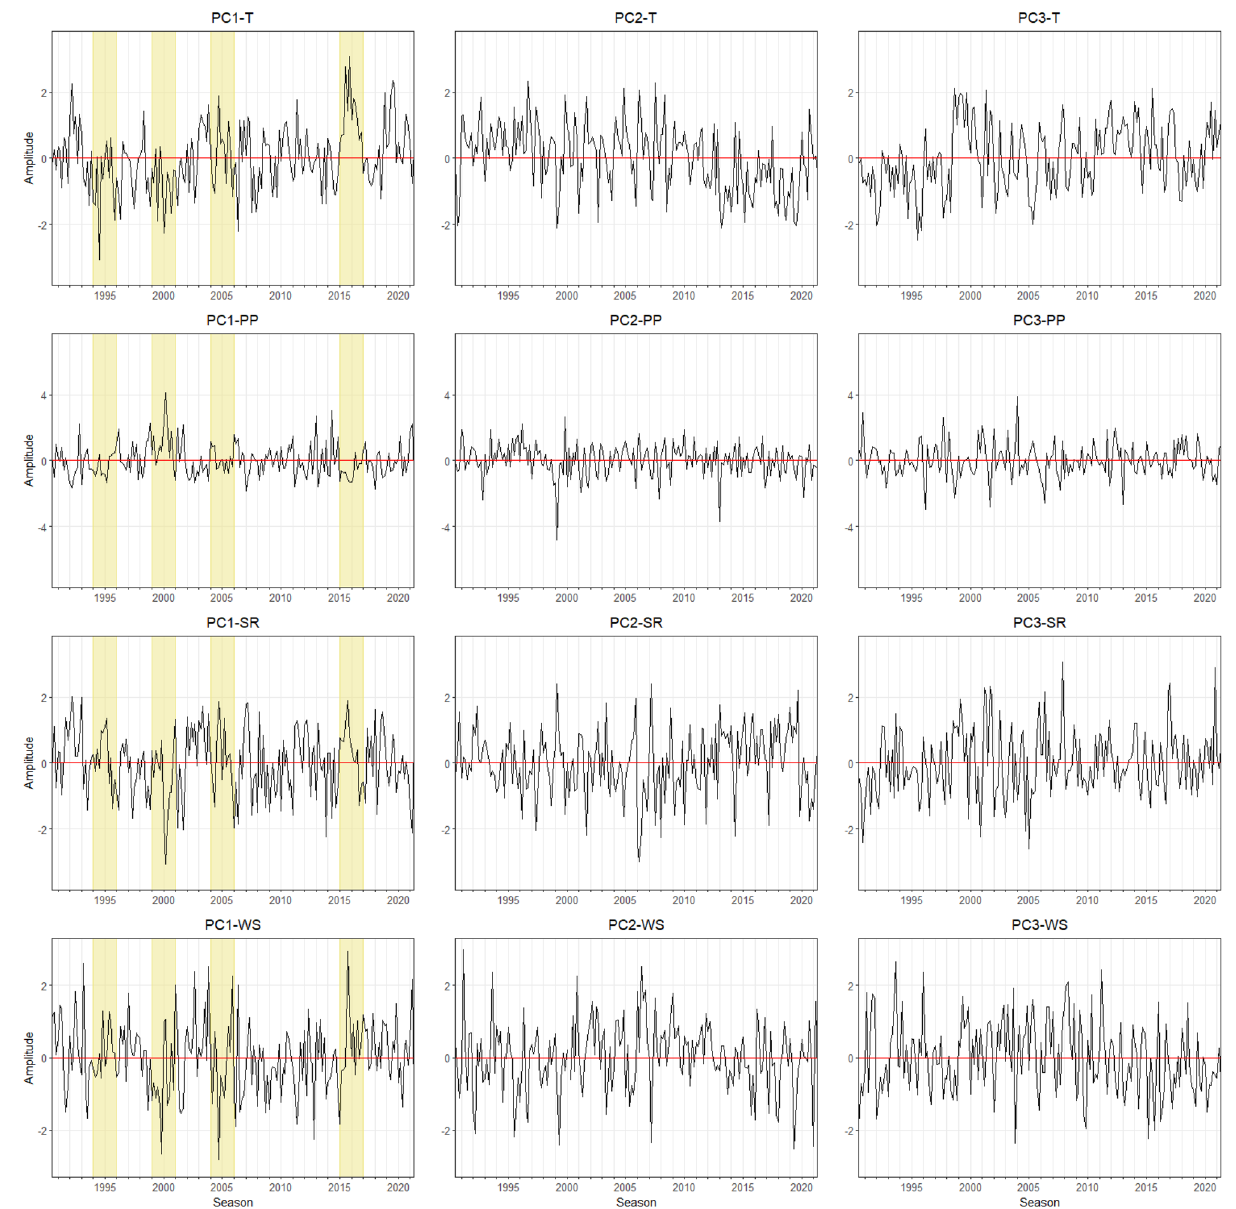
Figure 7. Monthly time series of growing season patterns (principal components, PC) corresponding to EOF- 1, EOF-2, and EOF-3 for the Mpumalanga province (see Fig. 6). Strong positive or negative anomalies of the dominant mode are highlighted (extreme events). The x-axis ticks indicate the beginning period of growing season. The abbreviations of agrometeorological data (T, PP, SR, WS) refer to Table